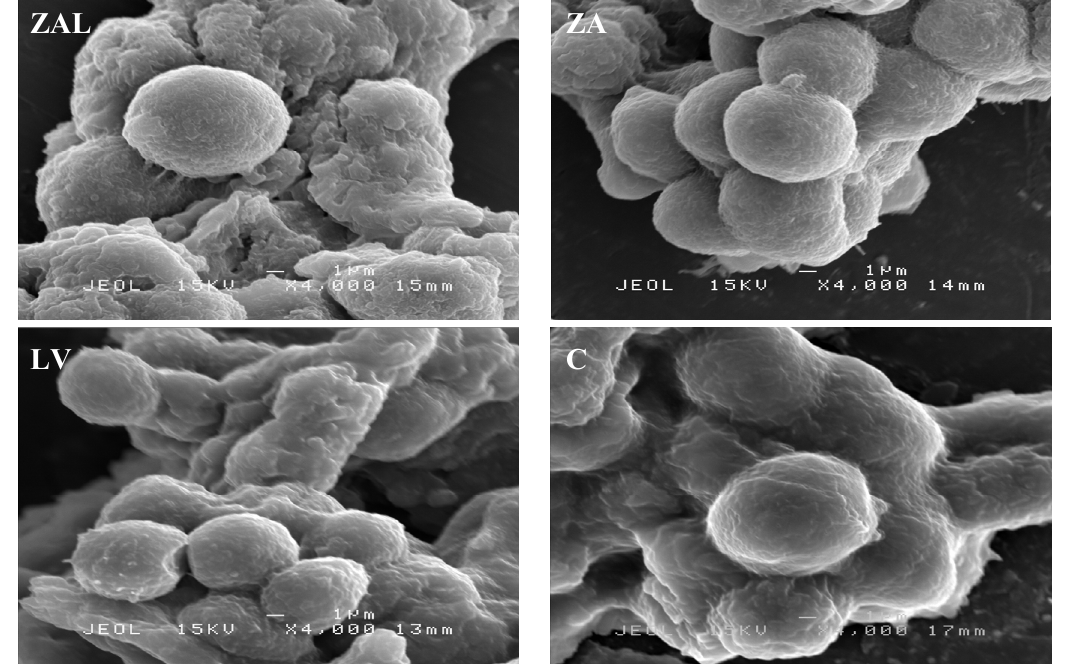
Figure 4. PC12 cell’s morphological appearance on scanning electron microscope (SEM) at ×4000 magnification after treatment with IC values obtained from MTT-proliferation 50 assay and viewed 72 h after treatment. ZAL, ZA, LV and C are the cells treated with zinc aluminum-levodopa nanoparticle, zinc aluminum nanoparticle, levodopa and control (untreated cells). The cells from treated samples ZAL, ZA and LV maintained a spherical appearance similar to that of cells from control sample C. Scale bar = 1